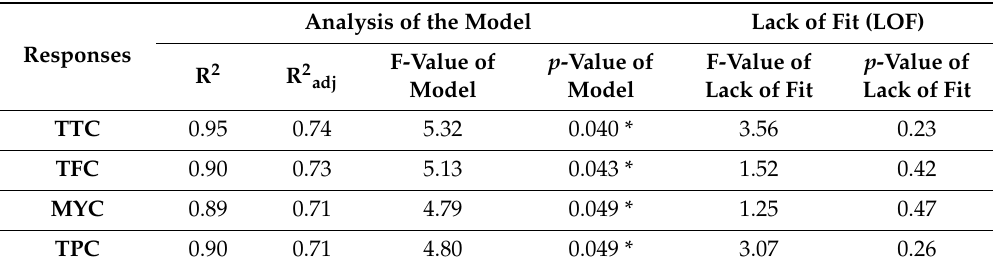
Table 3. Statistical parameters after data analysis and fit of the models obtained for the di ff erent